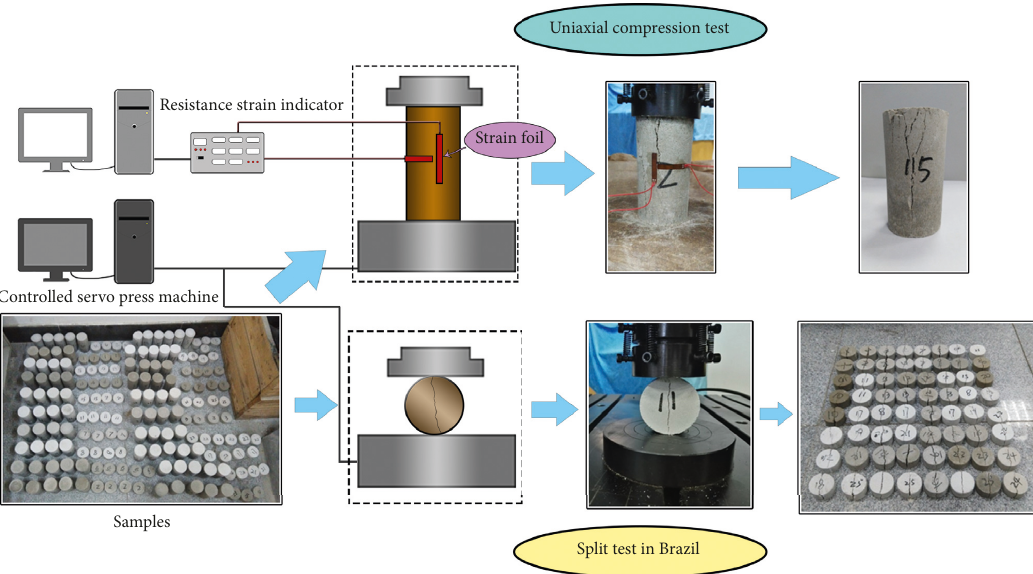
Figure 2: Tests about mechanical properties of